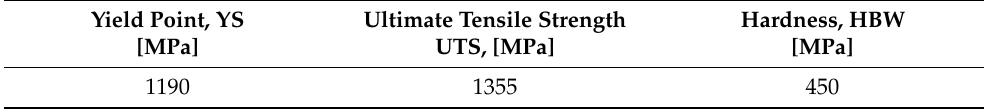
Table 1. Mechanical properties of the Hardox 450 steel